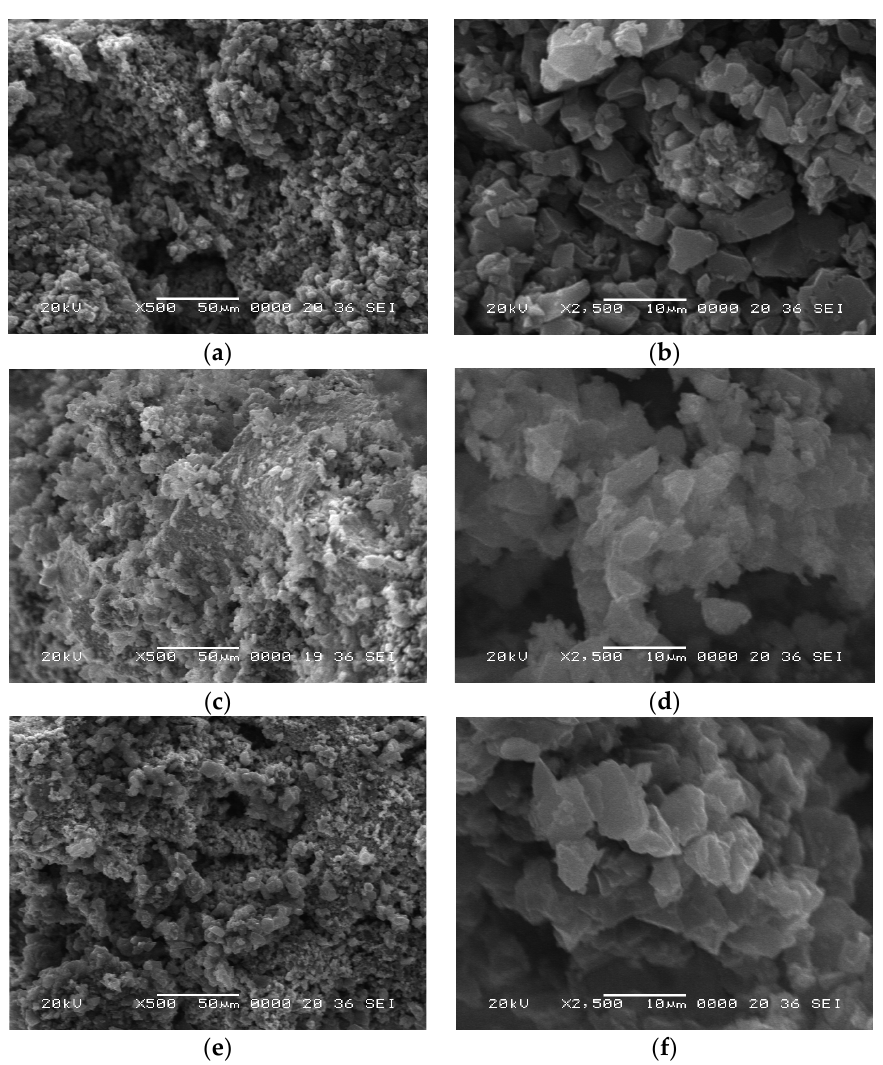
Figure 2. SEM analysis performed to study the surface state of the electrode after the electrode reaction; ( a , b ) YP80_CNT1, ( c , d ) YP80_CNT2, and ( e , f ) YP80_CNT3.